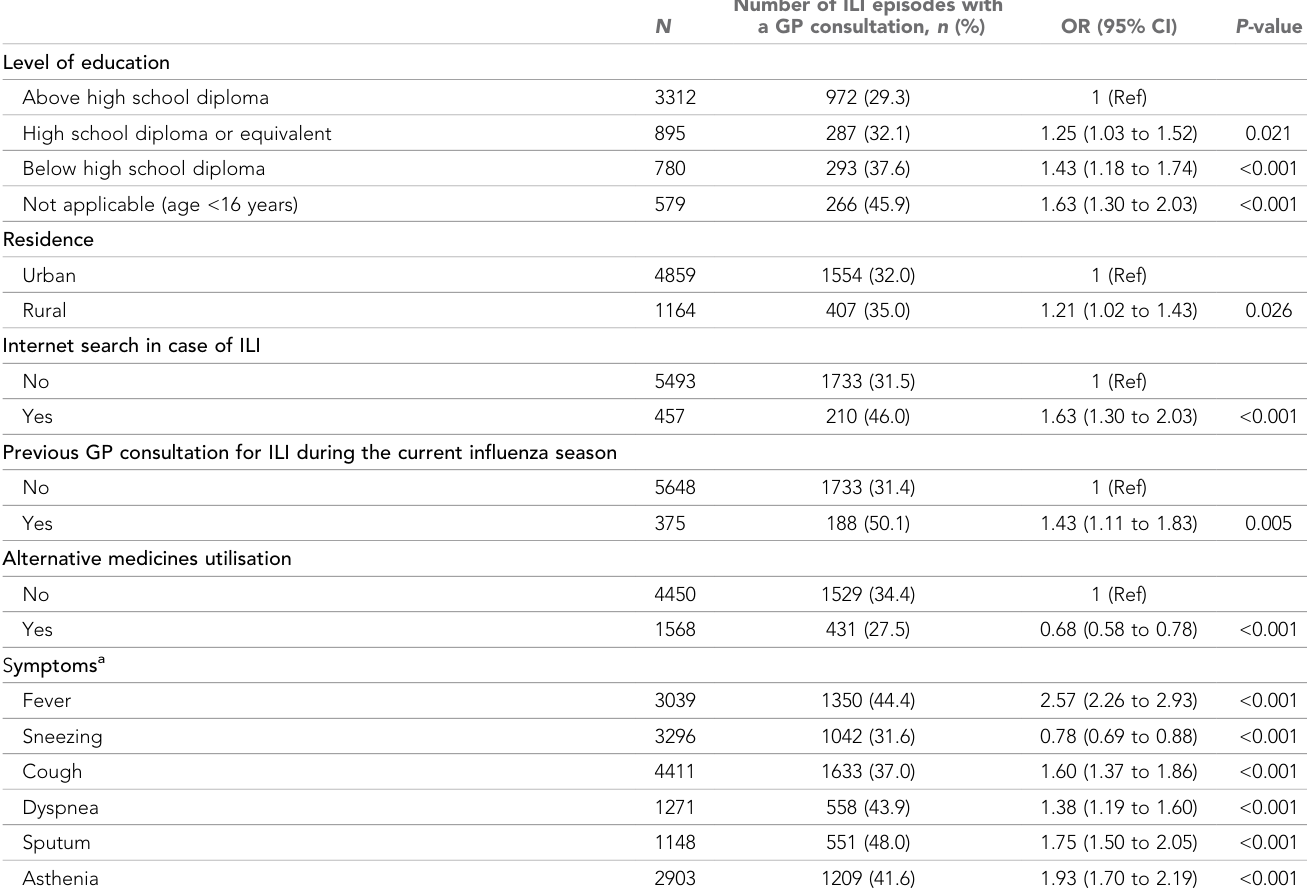
Table 5. Significant factors associated with GP consultation for ILI in France between 2012 and 2015 in multivariate analysis